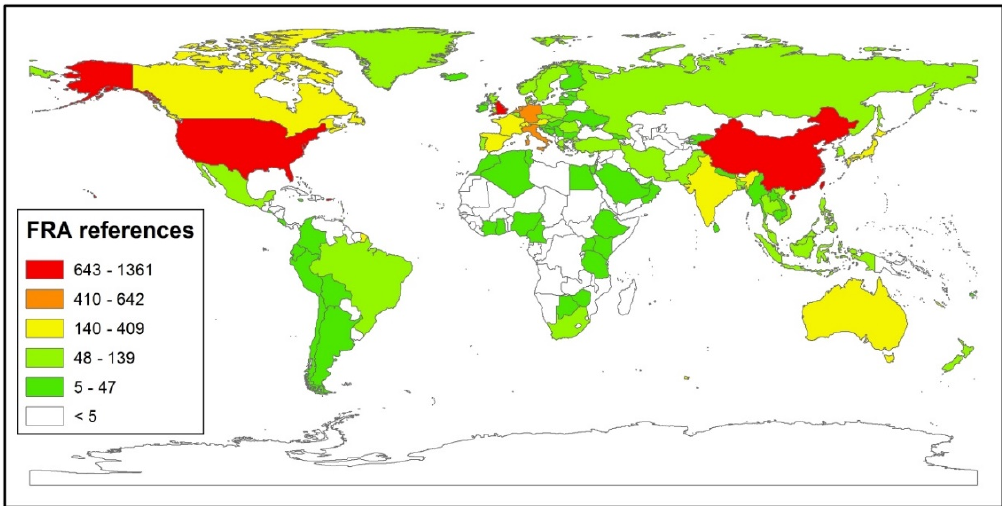
Figure 5. World map showing the number of FRAs references (records) in WoS databases classified by ‘Countries /Regions’, indicating the top 100 countries.